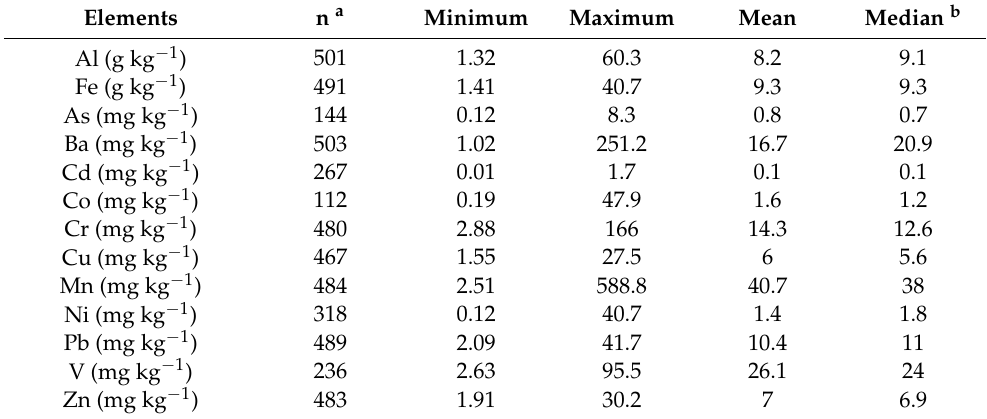
Table 2. Concentrations of potentially toxic elements in soils (0–0.2 m) of the State of Par á . Elements